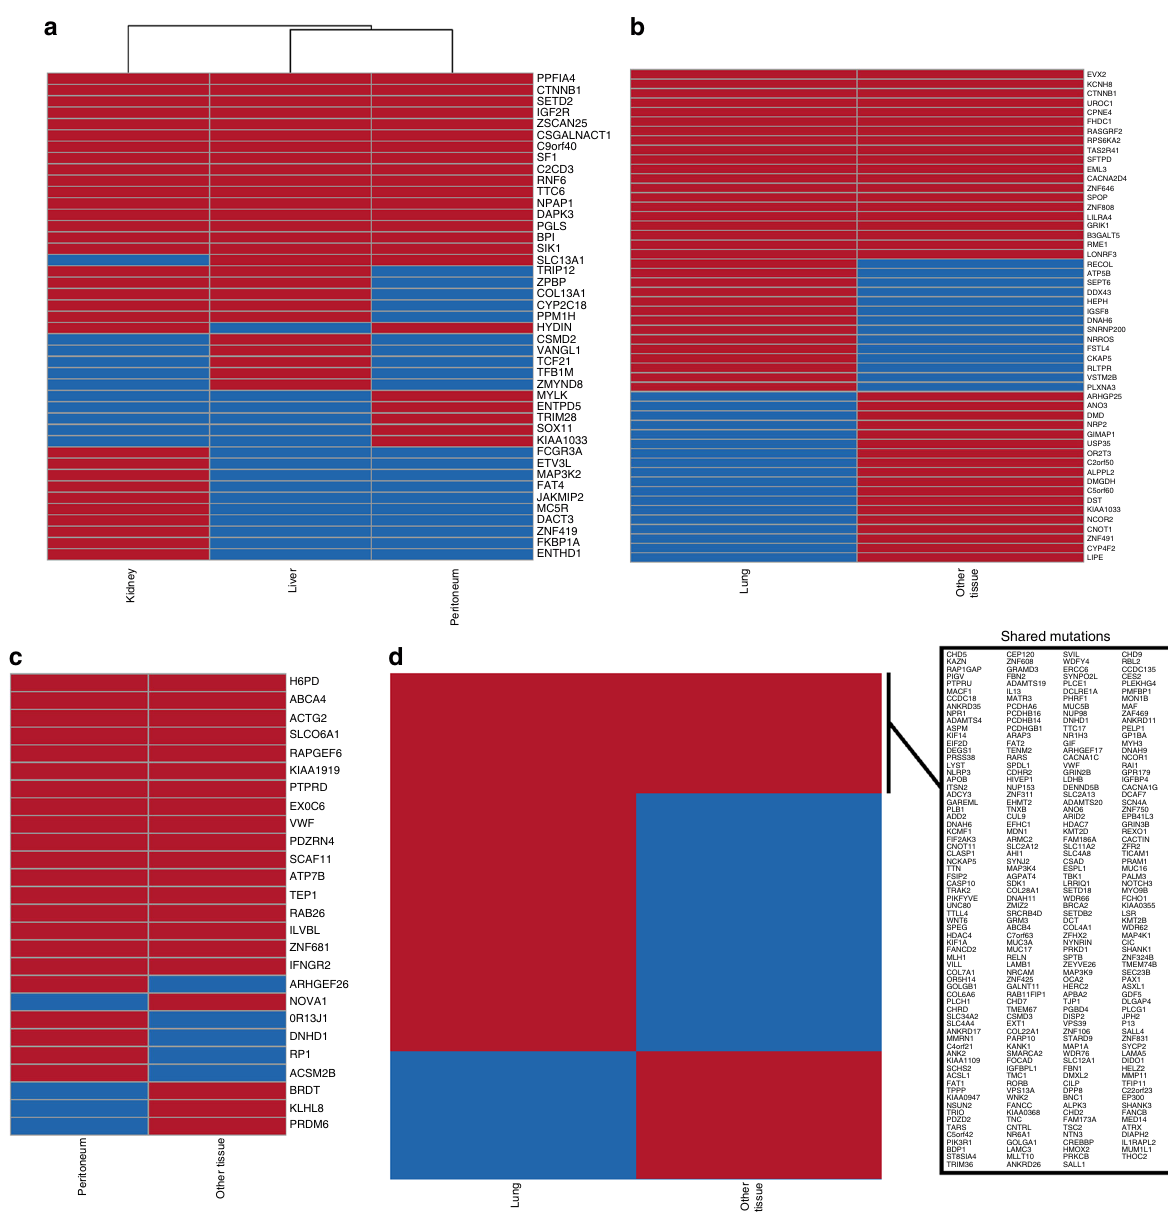
Fig. 3 Different metastatic ACC sites within the same patient are predominantly homogenous. Heatmap and clustering of the total number of overlapping and non-overlapping variants within the genes that are mutated in multiple tumor sites from each patient ( a – d ). The list of genes with shared mutations between lung and other tissue in the hypermutated patient ( d ) were shown in a box. Red bar in the heatmap indicates the gene is mutated, whereas the blue represents that the corresponding gene is wild-type in each